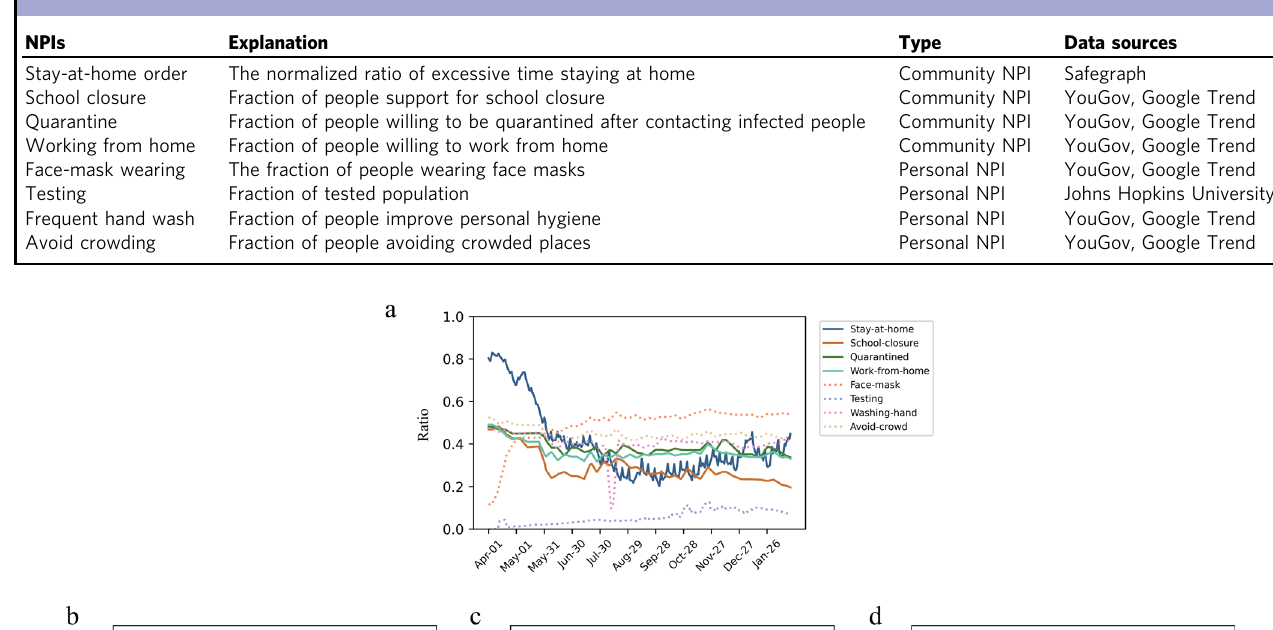
Table 2 Non-pharmaceutical interventions considered.